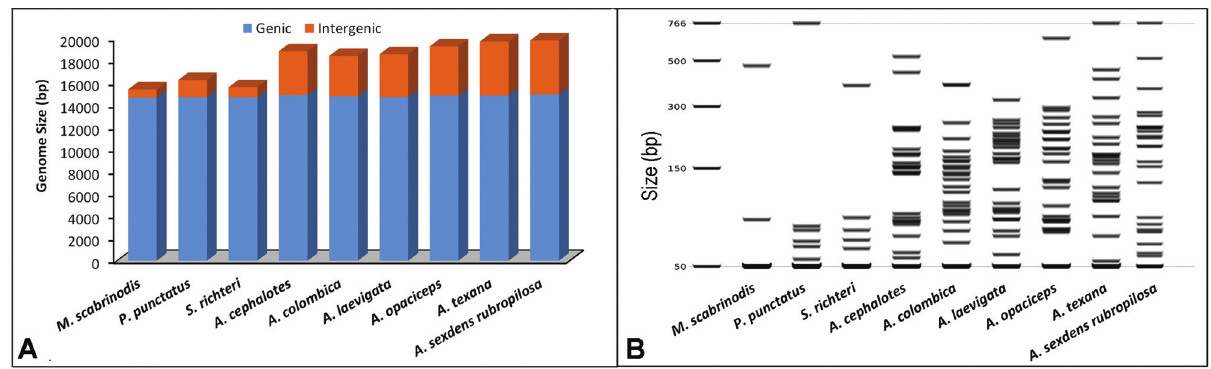
Figure 2 - Genome size of the complete mitogenomes for Atta genus and outgroup. (A) Distribution of the genic and intergenic spacers. (B) Virtual gel showing the distribution of the intergenic spacers.